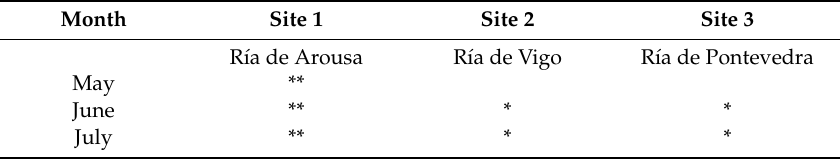
Table 1. Number of sampling points (*) considered in the exploratory study.